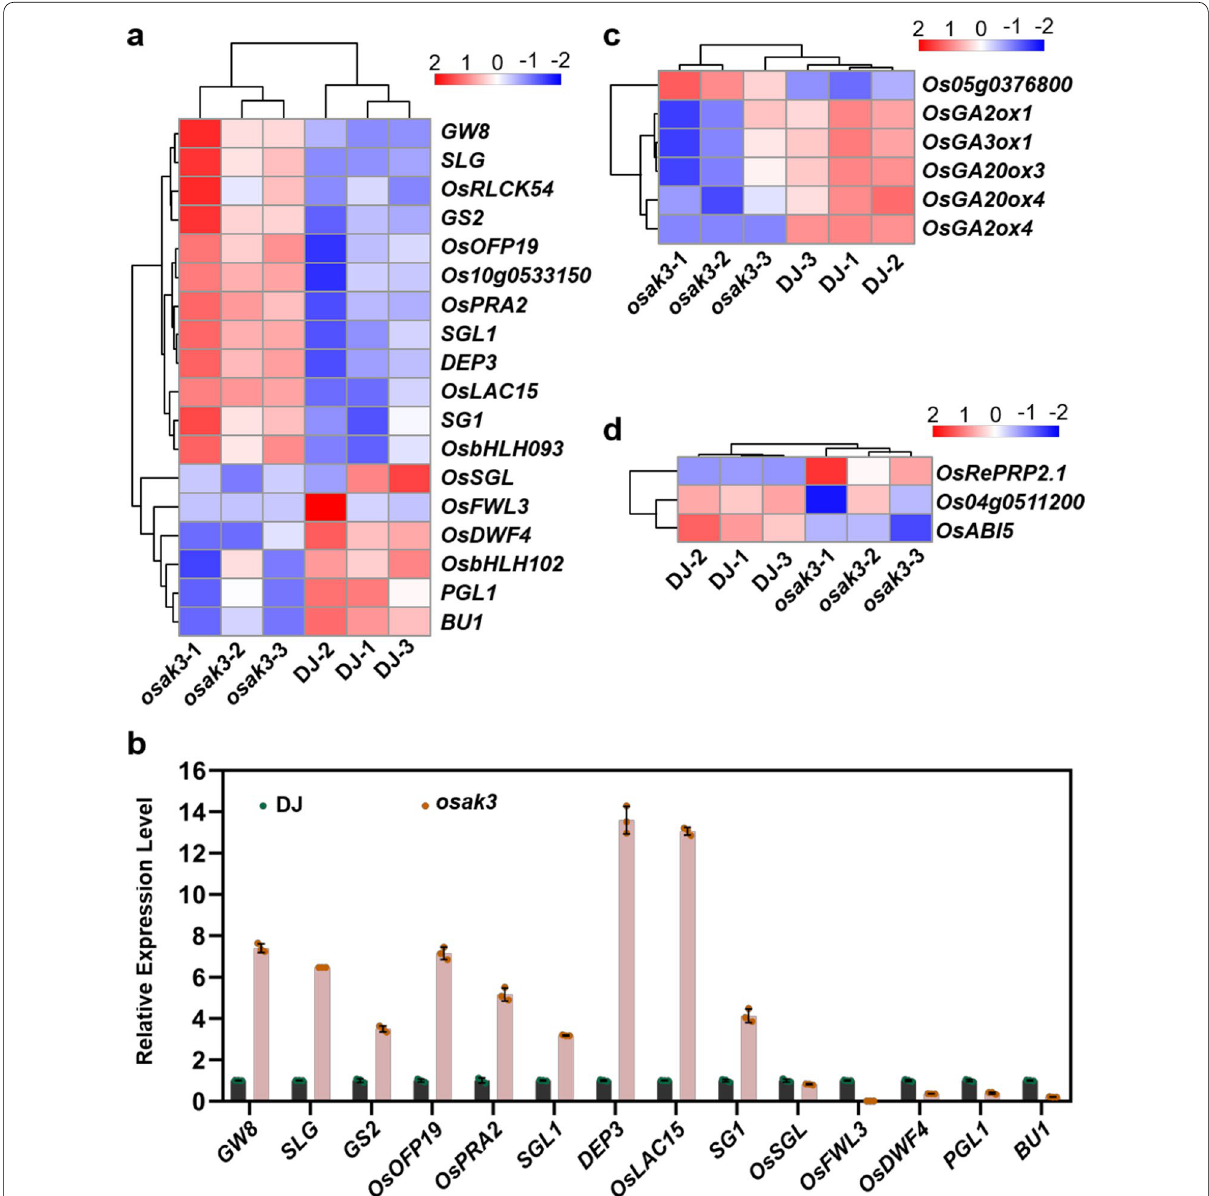
Fig. 8 OsAK3 is involved in multiple phytohormone signaling pathways. a Heat map of the grain size- and/or BR-related genes screened from DEGs. Scale bar shows fold changes, values are normalized by z-score scheme, red and blue color indicate up- and down-regulated, respectively. b RT-qPCR validation of the grain size- and/or BR-related genes screened from DEGs. Data are means to gibberellin ( c ) and abscisic acid ( d ). Scale bar shows fold changes, values are normalized by z-score scheme, red and blue color indicate up- and down-regulated,